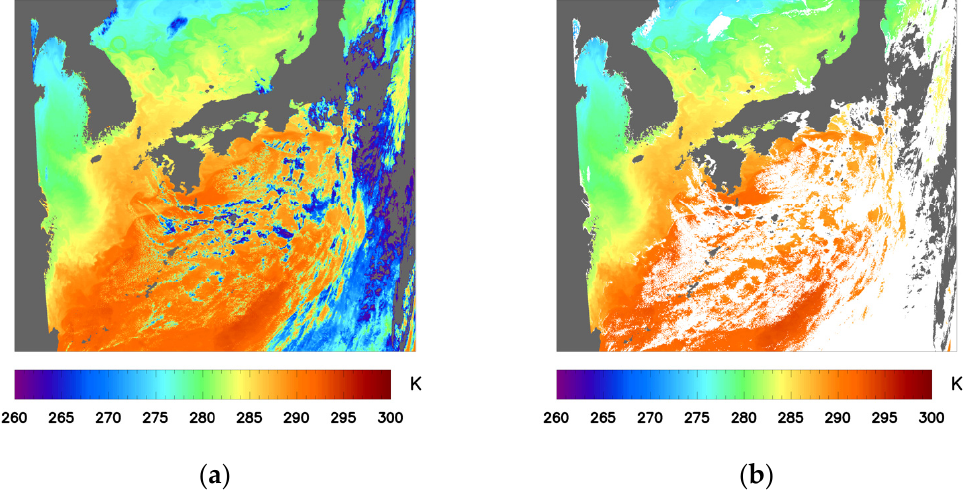
Figure 8. VIRR L1B 11 μ m channel BT before and after cloud detection: ( a ) before cloud detection; ( b ) after cloud detection (The gray areas are the pixels exceeding the study area, land, and obviously cloud (pixels with the BT of 11 μ m channel less than 260 K), the white areas are the pixels detected by Bayesian method as cloud).